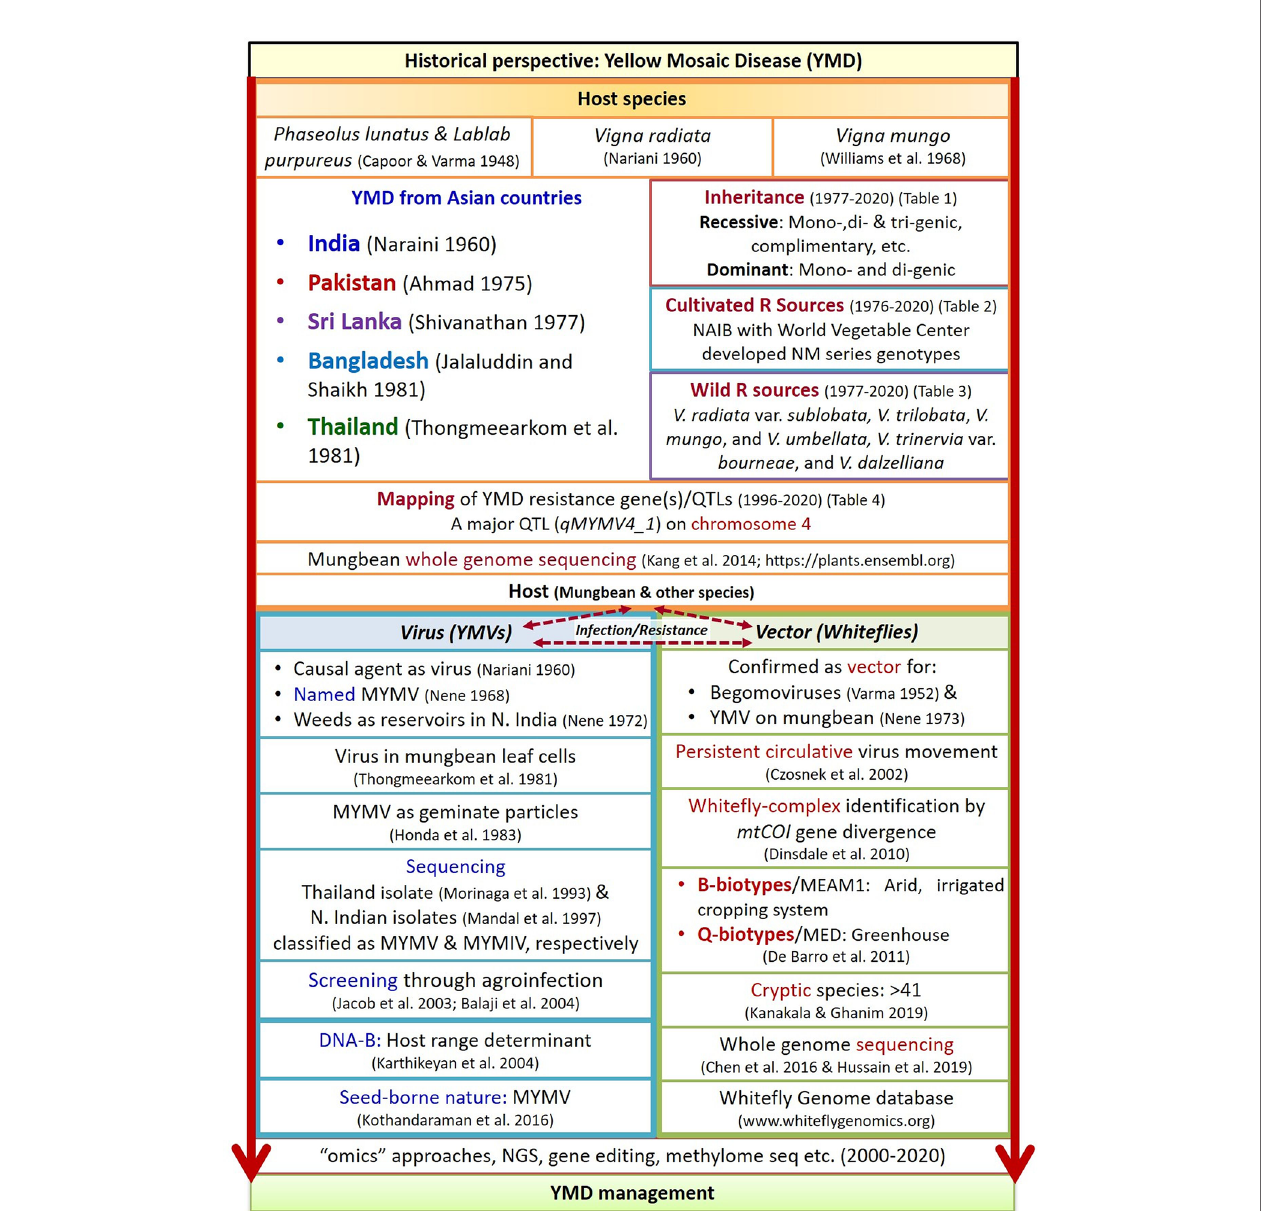
FIGURE 2 | Historical sketch of YMD in mungbean crop (Derived from Capoor and Varma, 1948; Capoor and Varma, 1950; Varma, 1952; Nariani, 1960; Nene, 1968; Williams et al., 1968; Nene, 1972; Nene, 1973; Ahmad, 1975; Shivanathan, 1977; Jalaluddin and Shaikh, 1981; Thongmeearkom et al., 1981; Honda et al., 1983; Morinaga et al., 1993; Mandal et al., 1997; Czosnek et al., 2002; Jacob et al., 2003; Balaji et al., 2004; Karthikeyan et al., 2004; Dinsdale et al., 2010; De Barro et al., 2011; Kang et al., 2014; Chen et al., 2016; Kothandaraman et al., 2016; Hussain et al., 2019; Kanakala and Ghanim, 2019). Where, R, resistance; YMVs, yellow mosaic viruses; NGS, next generation